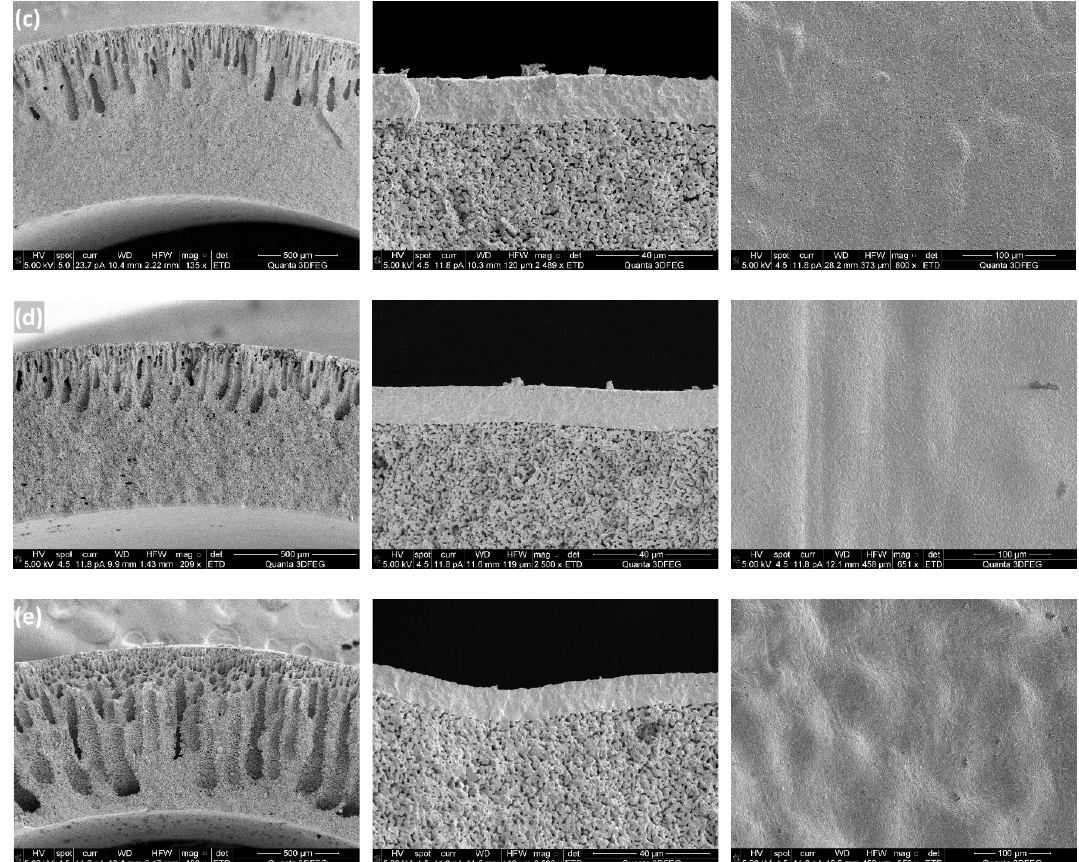
Figure 5. SEM images of MgO-CGO porous supports fabricated from slurries with ( a ) 60 wt%, ( b ) 56 wt%, ( c ) 50 wt%, ( d ) 47 wt% and ( e ) 43 wt% ceramic loadings together with the CGO layers coated inside.